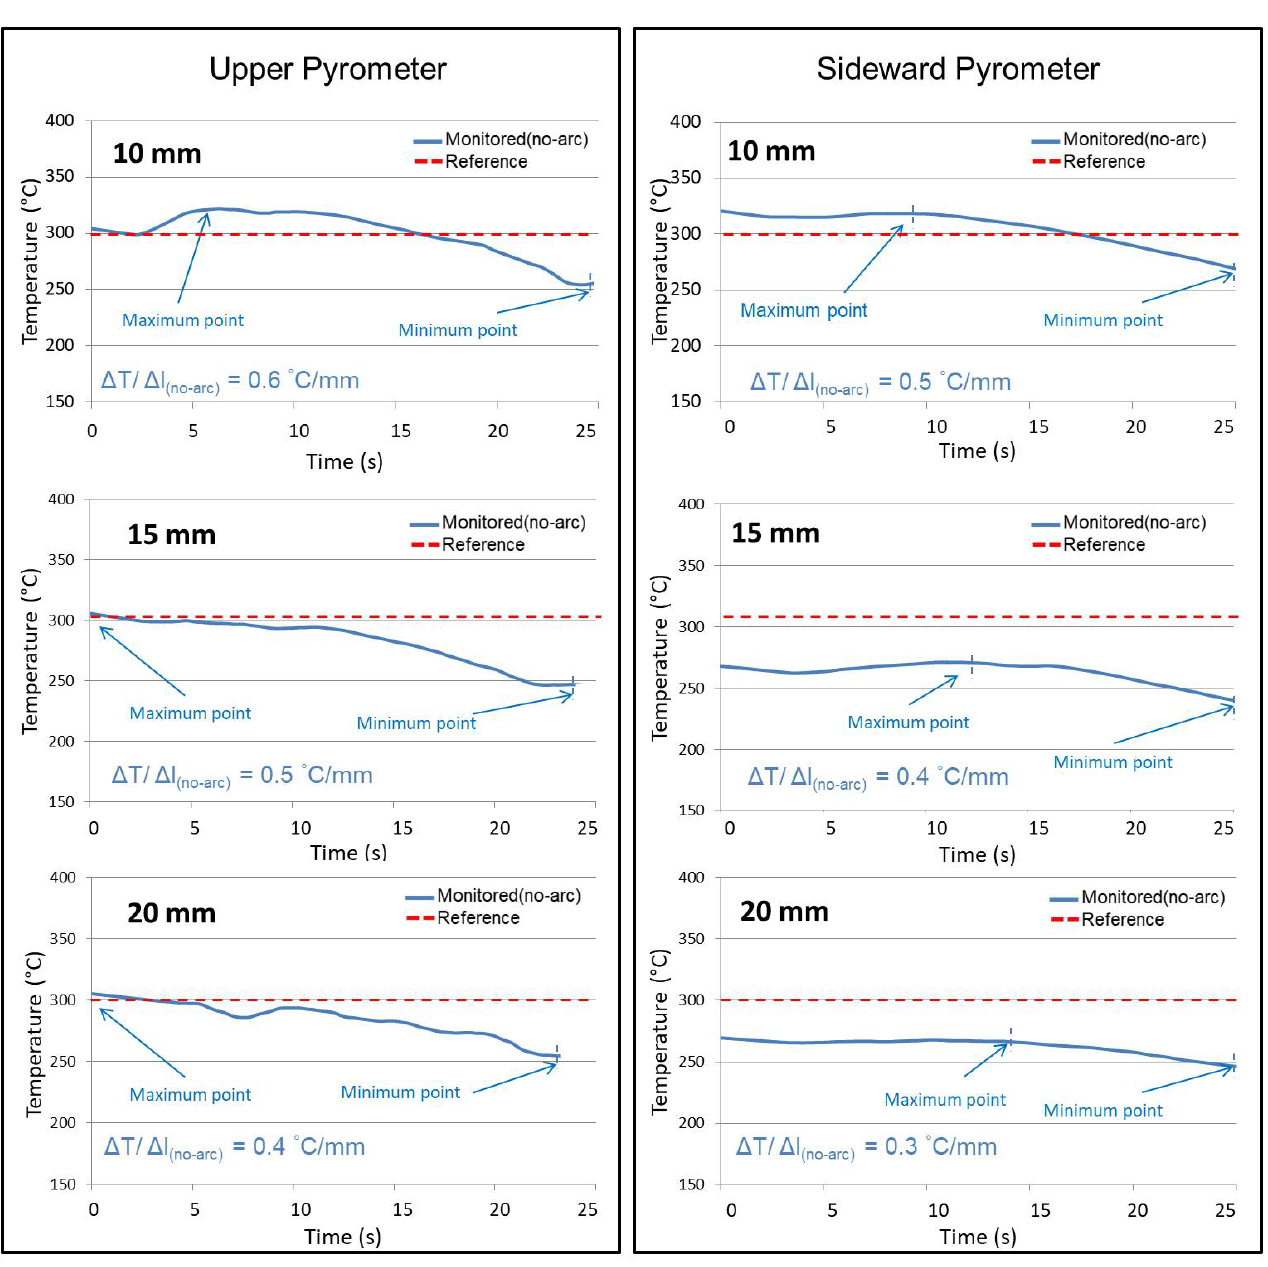
Figure 8. Typical temperature profiles resultant from the two pyrometer approaches with the torch movement without an arc (no-arc condition), for different measurement distances “L”, where ∆ T/ ∆ l (no-arc) is the temperature gradient from the representative maximum and minimum tempera- tures (the reference temperature of 300 °C for the torch movement start is that from the Upper Py- rometer).